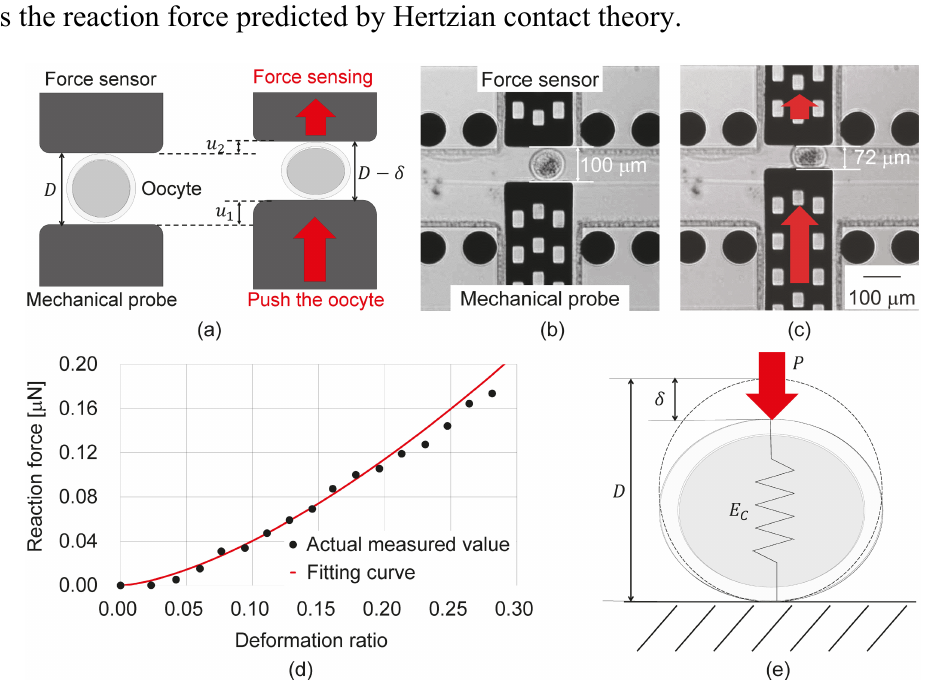
Figure 10. Mechanical characterization of oocytes: ( a ) Concept of measurement; ( b ) photograph taken before measurement; ( c ) photograph taken during measurement; ( d ) deformation ratio vs . reaction force; ( e ) model of Hertzian contact